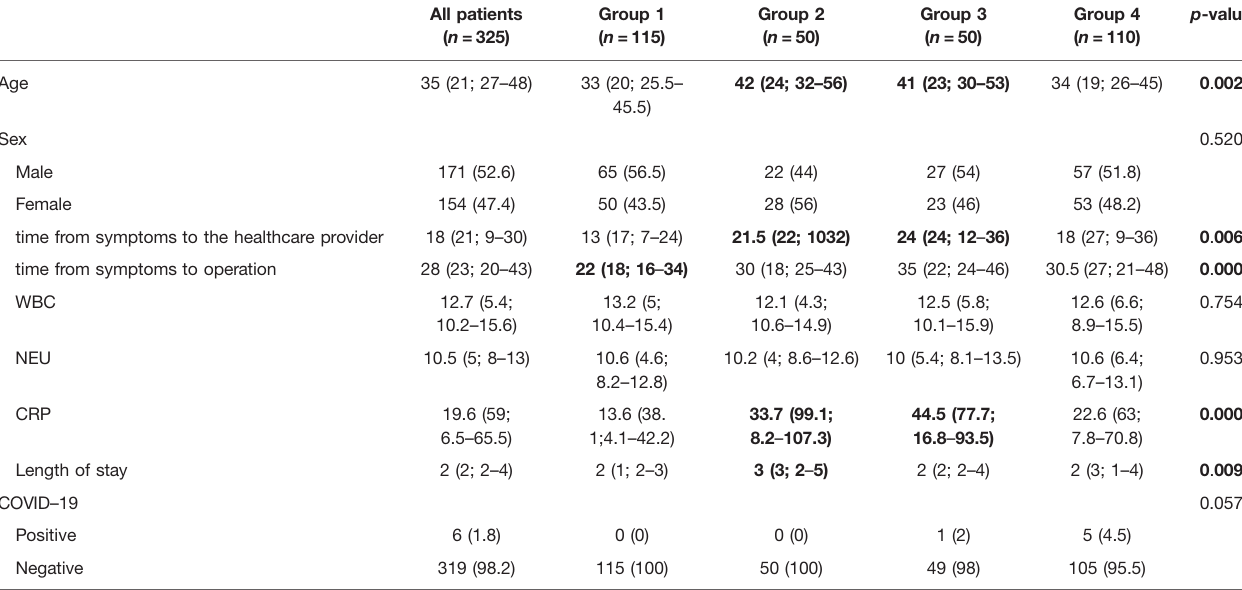
TABLE 2 | Cohort of con fi rmed acute appendicitis.